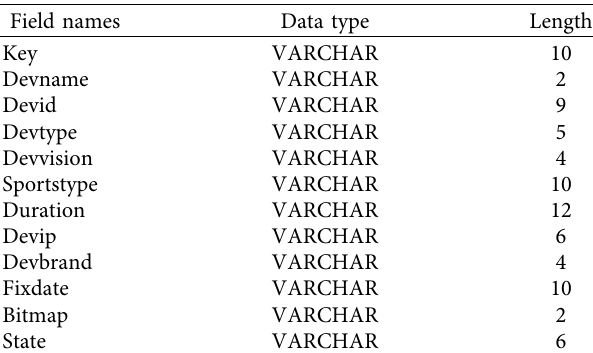
Table 4: Fitness equipment list.